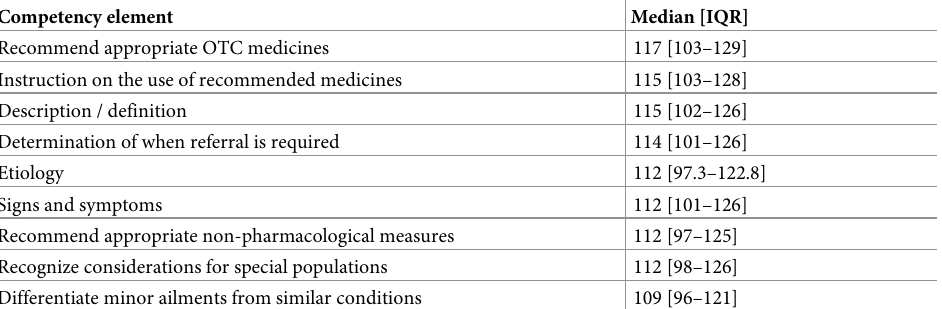
Table 3. Community pharmacists’ self-perceived competency for condition-specific elements (maximum obtain- able score per competency element for 14 minor ailments = 140).